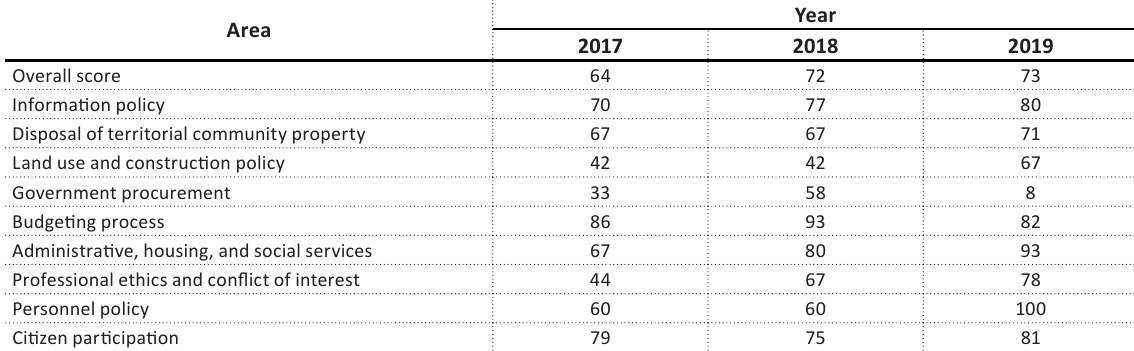
Table 4. Results of Sumy city transparency assessment for 2017–2019,